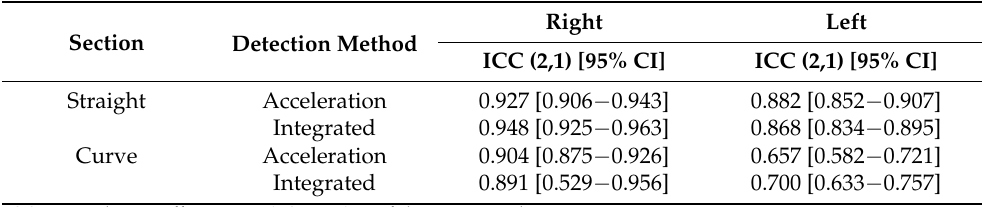
Table 5. The intra-class coefficient as computed by the acceleration and integrated detection methods.